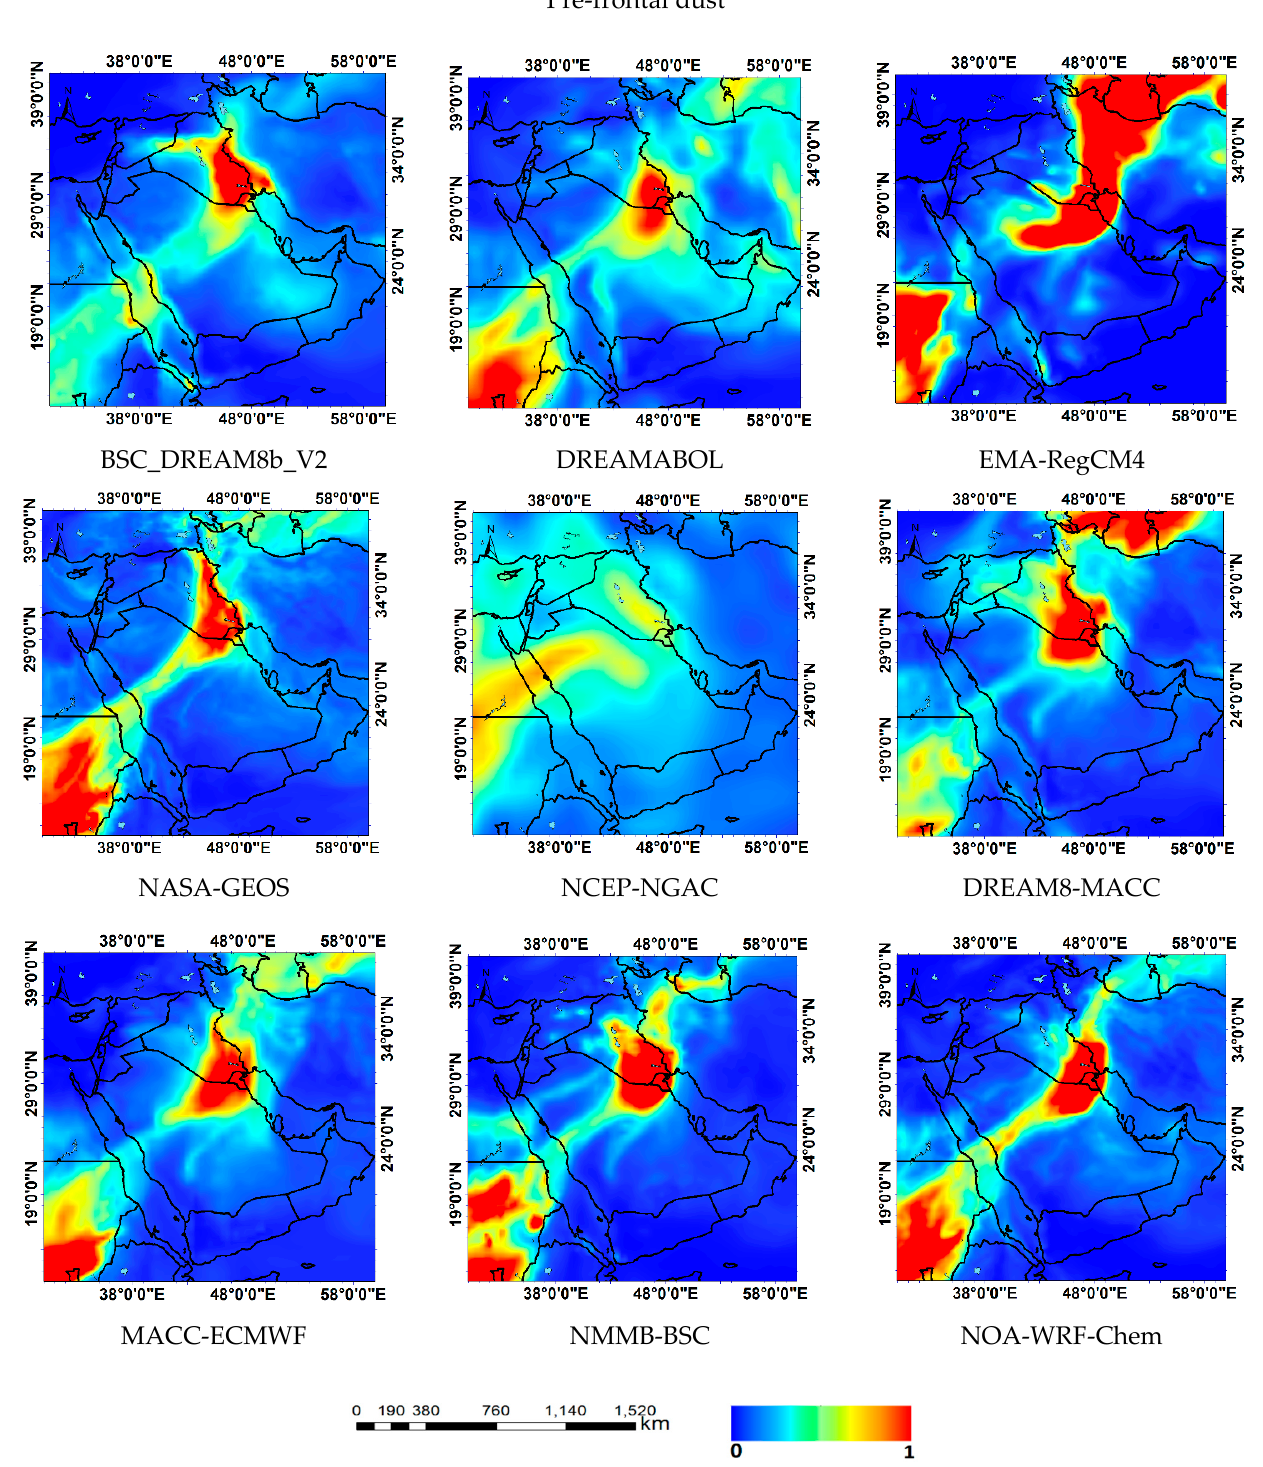
Figure 6. Spatial distribution of AOD forecasts from the nine examined models at 07:00 UTC on 30 March 2018 (pre-frontal dust storm).